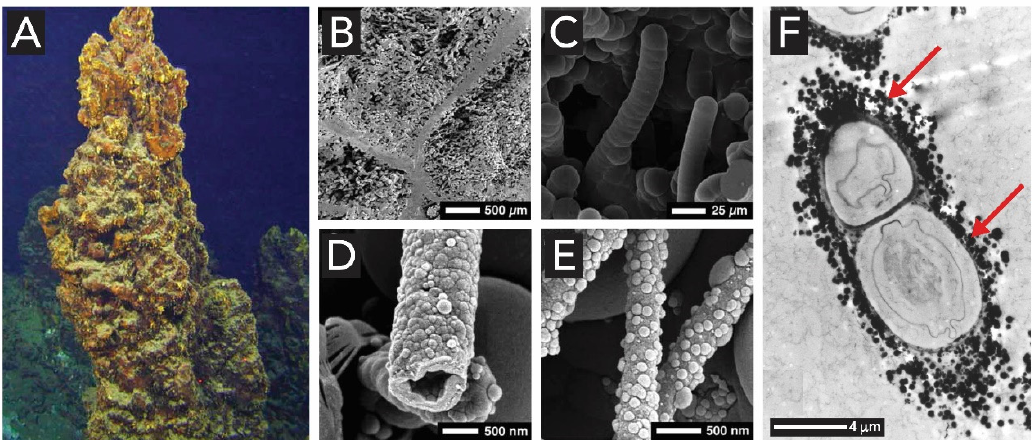
Figure 7. Silicified microbes. ( A ) Underwater photographs of silica-rich chimneys (~2 m) on the Giggenbach volcano. ( B – E ) SEM photomicrographs of silicified microbes: ( B ) Overview of silicified microbial mats with opal-A sheets. ( C ) Silicified filamentous microbe. ( D ) Silicified rod-shaped microbe showing a thin wall around an open lumen and small opal-A spheres on the outer surface. ( E ) Silicified rod-shaped microbes coated with opal-A and scattered opal-A spheres. ( F ) TEM cut of silicified bacteria from a geyser outflow channel, showing a filamentous cyanobacterium with silica spheroids on outer sheath (arrows). Images A–E are adapted from [79] with permission from John Wiley and Sons. Image F is reproduced from [80] with permission from Springer Nature BV.